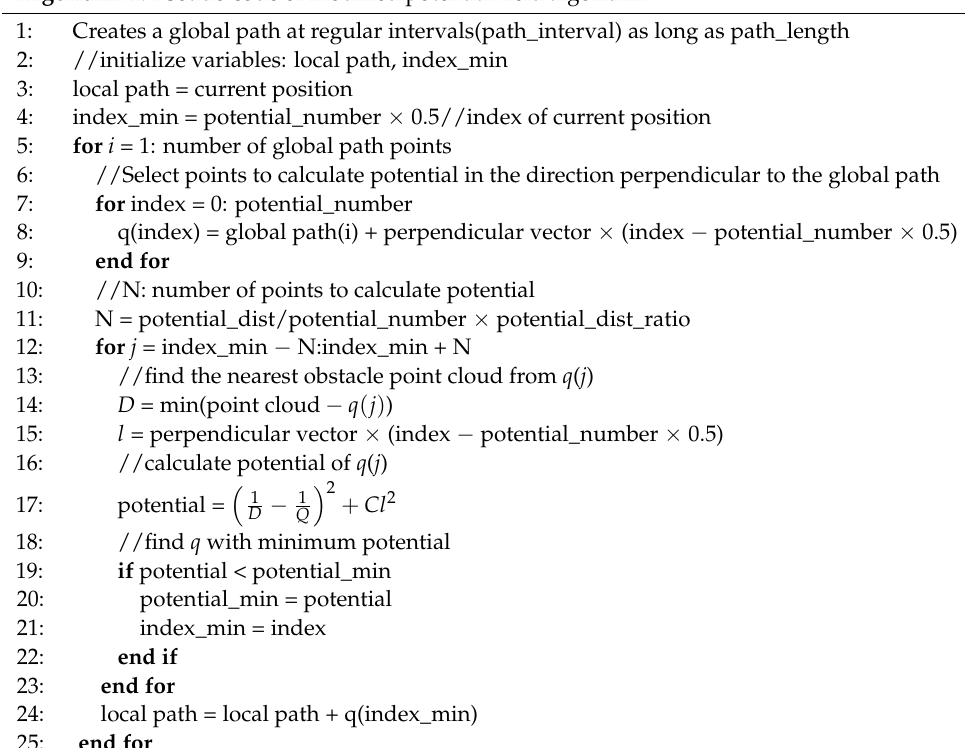
Algorithm 1: Pseudo code of modified potential field